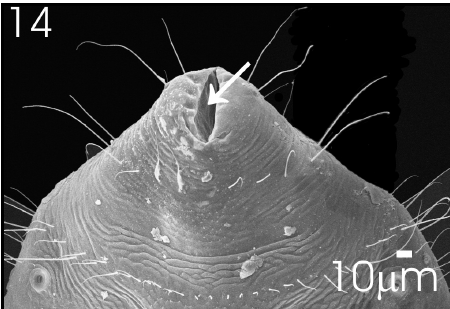
Fig. 14. The genital opening of the male showed no setae surrounding the slit (arrow).